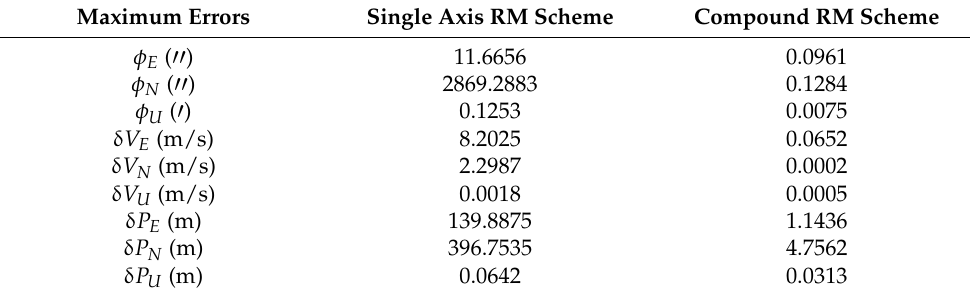
Table 7. Maximum errors between two rotational modulation schemes’ comparison.